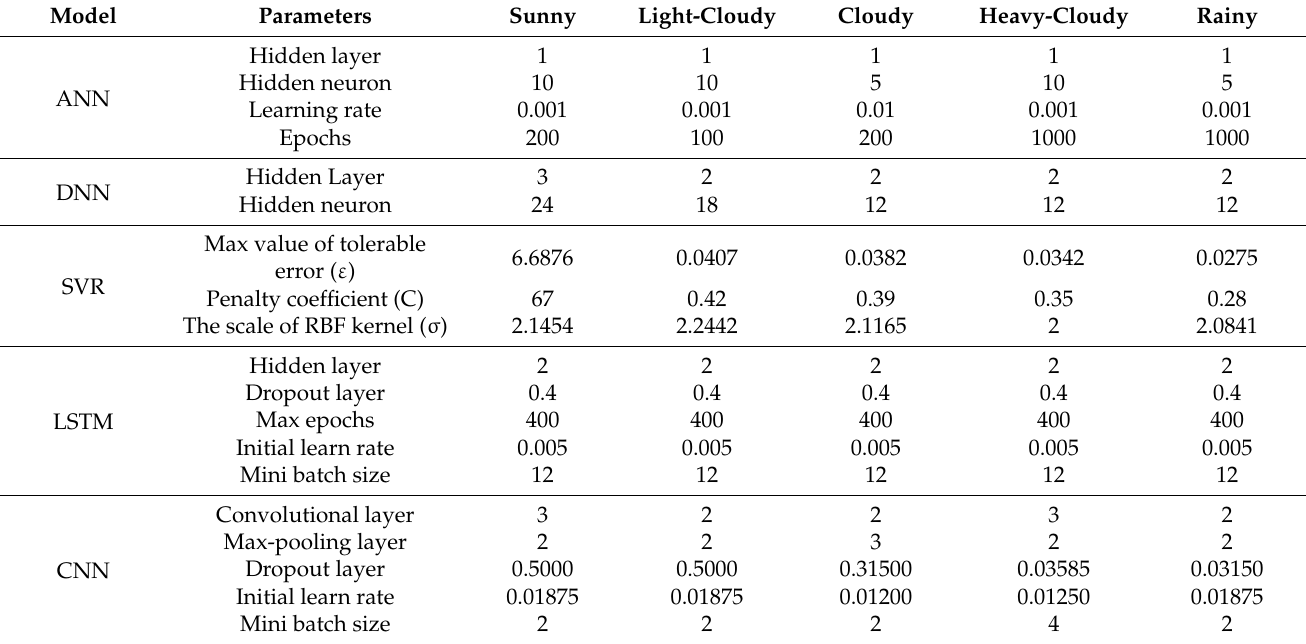
Table 4. Parameters of the single models.